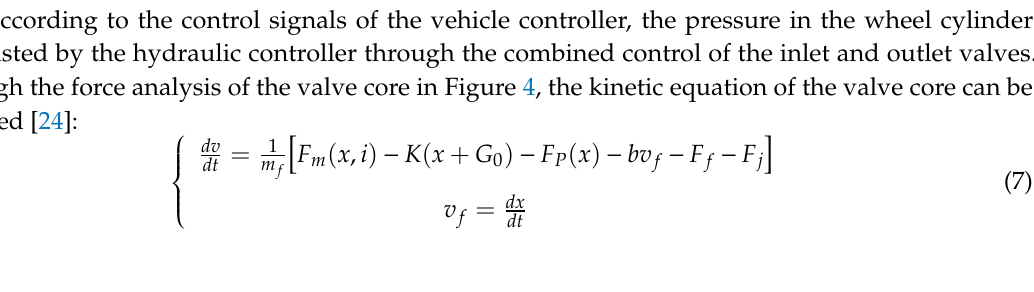
Figure 4. The structure diagram of the outlet valve and the force analysis of the core.